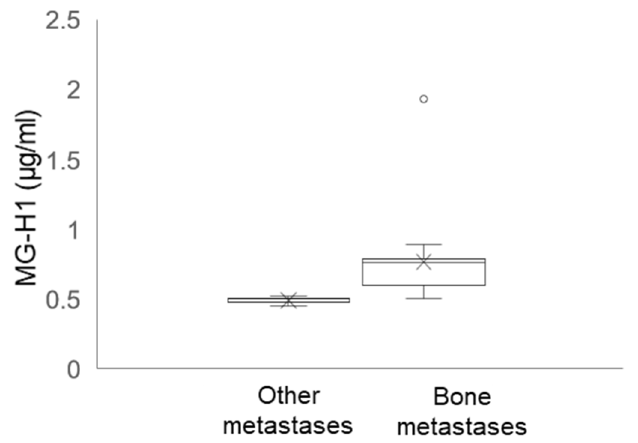
Figure 12. Circulating levels of 5-hydro-5-methylimidazolone (MG-H1) in bone metastasis-bearing patients divided into those with bone metastases ( n = 20) and those with metastases from other organs (other metastases, n = 10).